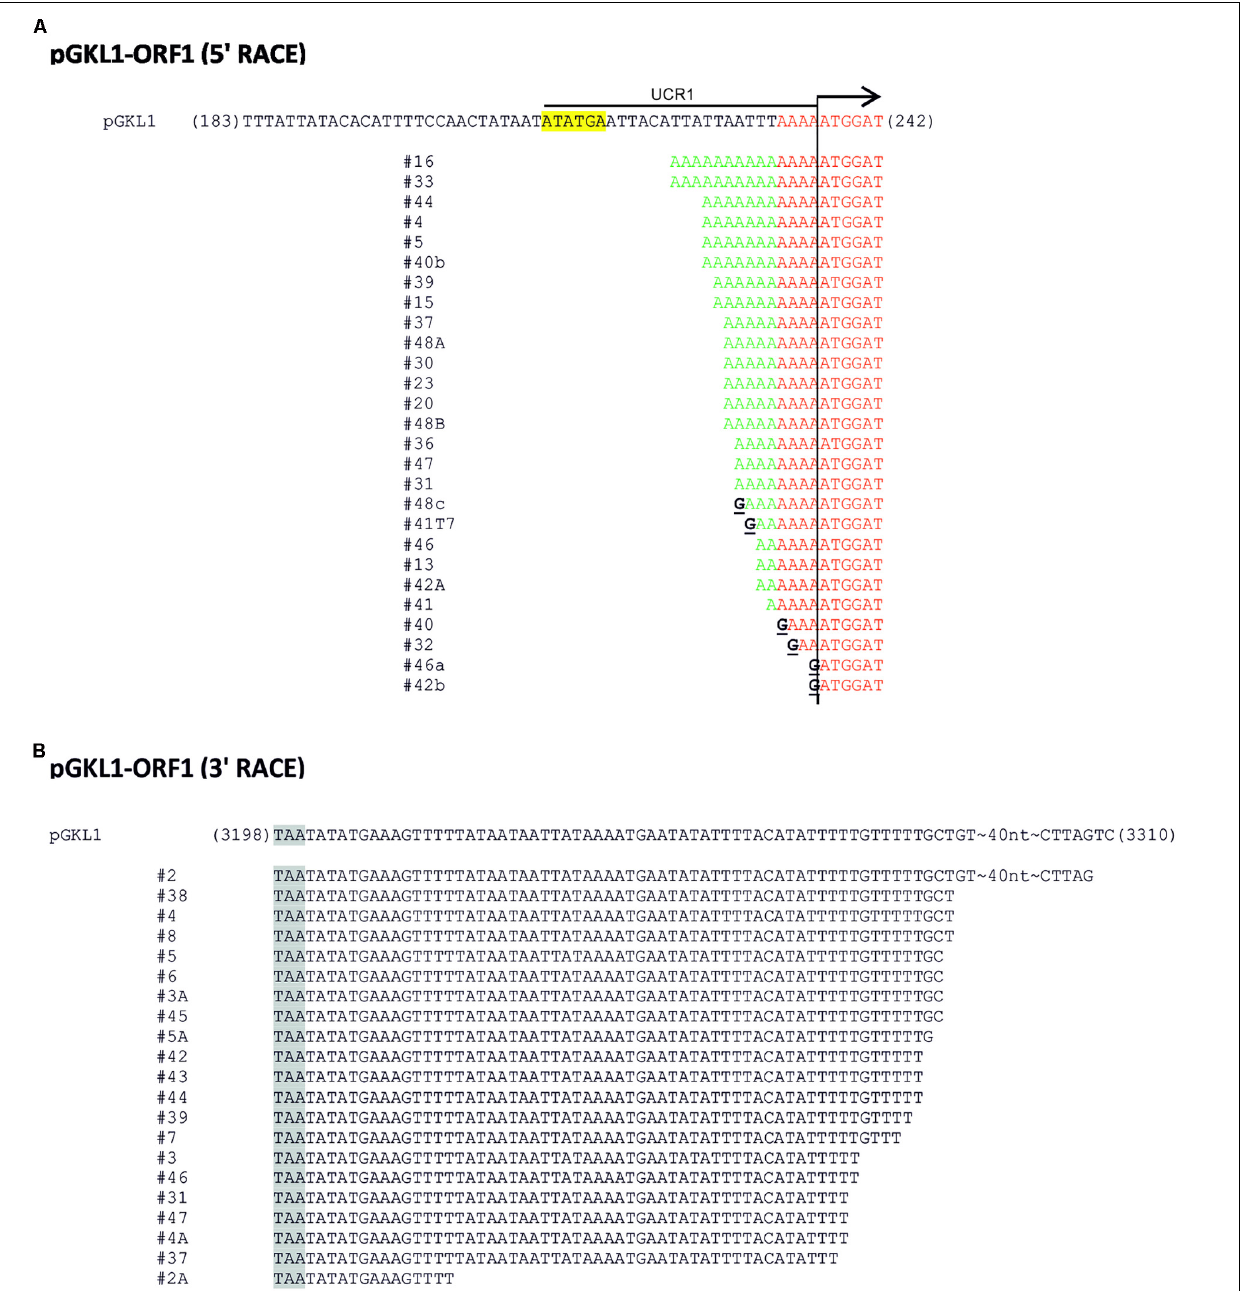
FIGURE 2 | 5 (cid:48) /3 (cid:48) RACE analysis of pGKL transcripts. (A,B) Representative pictures of 5 (cid:48) RACE (A) and 3 (cid:48) RACE (B) analyses of individual mRNAs transcribed from K1ORF1 encoded by the pGKL1 VLE. The top sequence corresponds to the template (VLE genomic) DNA; the cDNA sequences below represent individual clones obtained by the reverse transcription of individual mRNA molecules. In the case of 5 (cid:48) RACE (A) , sequences homologous to the template (VLE genomic) DNA are highlighted in red, and non-templated 5 (cid:48) leaders of the mRNA transcripts are in green. Guanosine nucleotides uncovered as cytosines during the first strand cDNA synthesis and corresponding to the 5 (cid:48) mRNA caps are depicted in black and underlined. K1UCR1 , which was also used as a promoter sequence in other experiments, is underlined. K1UCS1 is highlighted in yellow. (B) Sequences obtained by 3 (cid:48) RACE. Stop codons are highlighted in gray. For details concerning transcripts of other pGKL ORFs, please refer to Supplementary Tables S5A,C and the description therein.